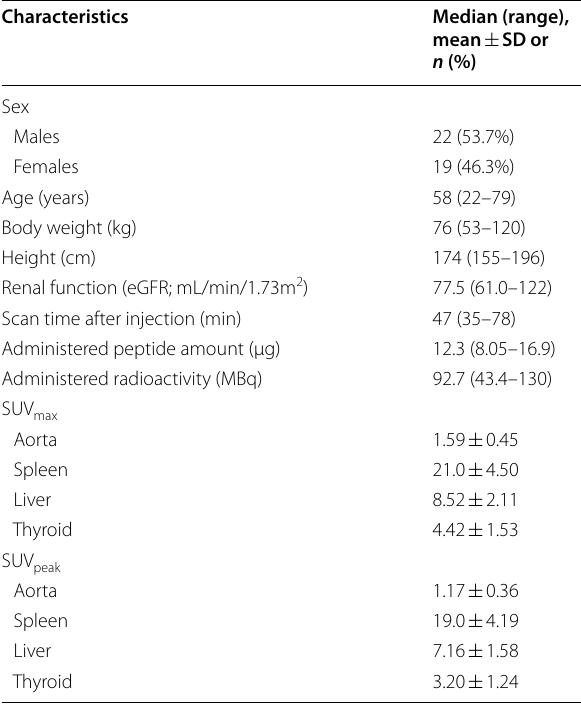
Table 1 Patient characteristics and demographics